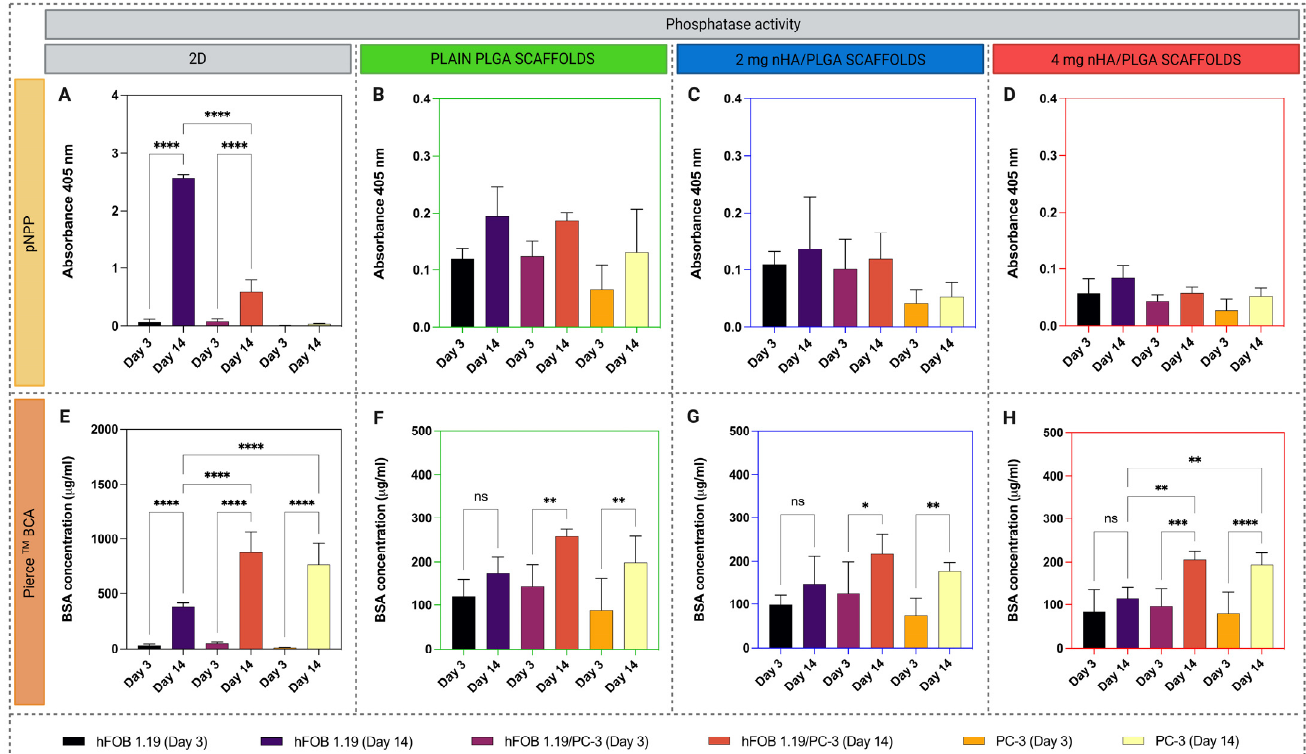
Figure 8. Quantitative analysis of phosphatase and protein content produced by mono- and co-cul- ture set-ups at days 3 and 14. ( A – D) pNPP absorbance values in ( A ) 2D and ( B – D ) 3D scaffolds in all the culture setups with corresponding ( E – H ) total protein content. Values are expressed as the mean ± SD. The data represents 2 independent experiments with n = 6 replicates per sample type. Note: different scales are used on the y-axis in B-D and F-H due to the lower enzyme and protein content in the 3D cell cultures. * p < 0.05, ** p < 0.01, *** p < 0.001, **** p <